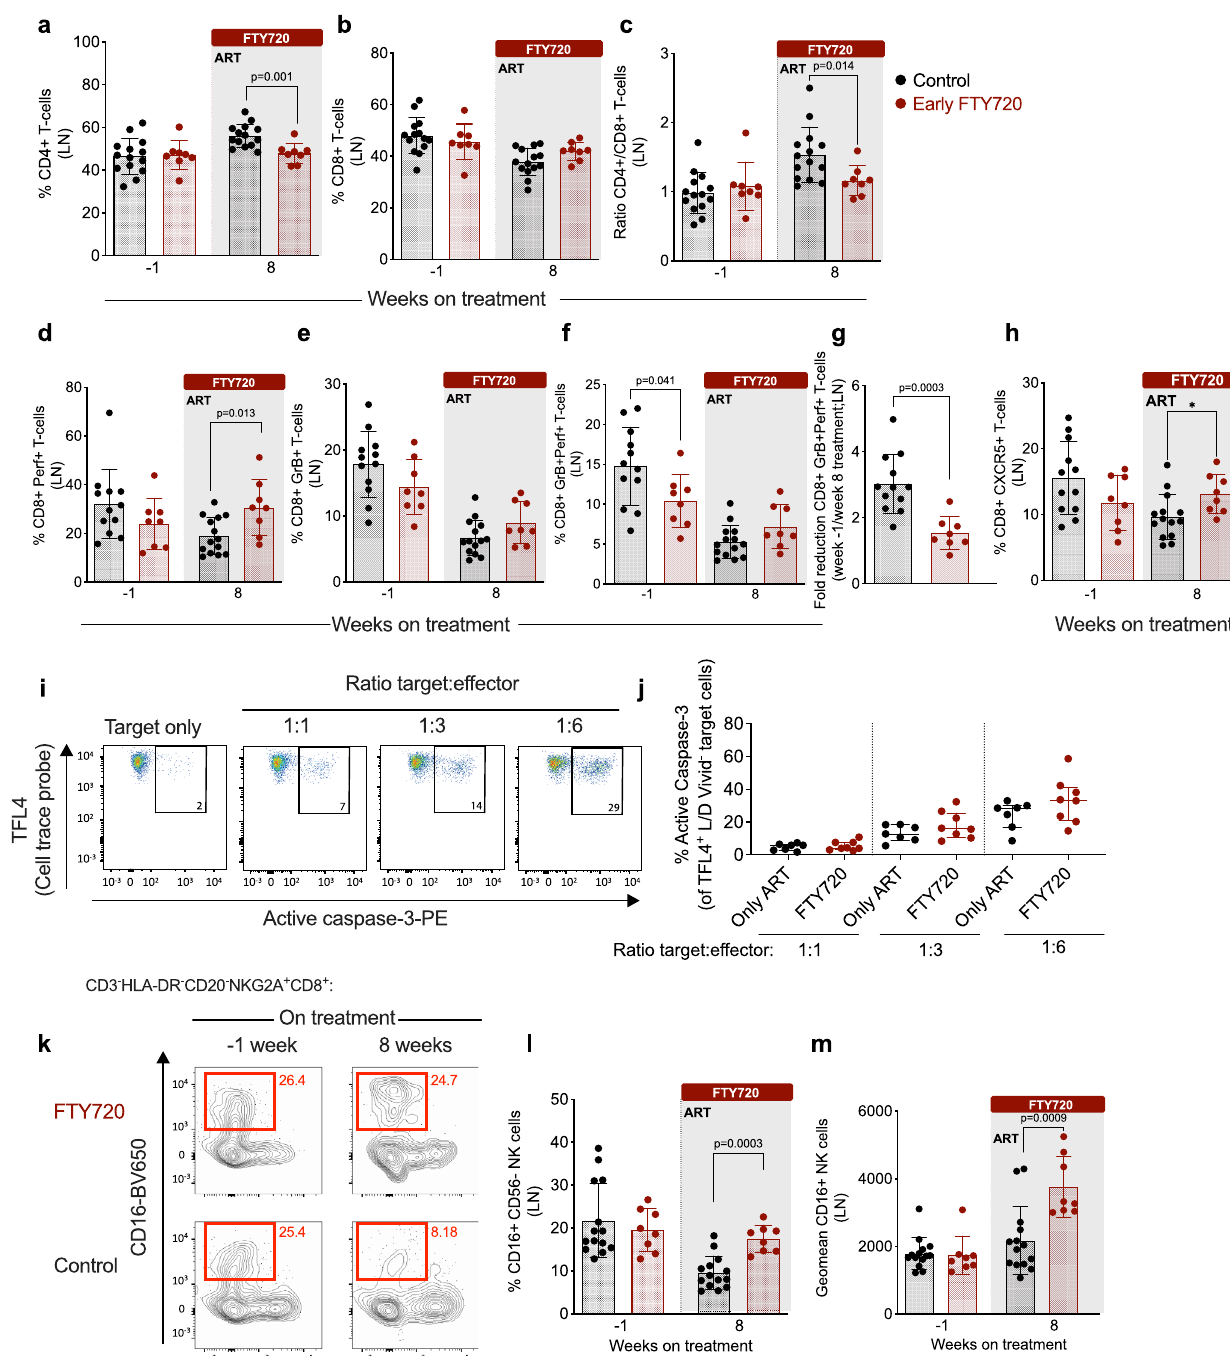
Fig. 2 | FTY720 treatment in the fi rst weeks of ART retains cytolytic cells but does not enhance their functionality in the LN. a Frequency of CD4+ T cells, b CD8+Tcells,and( c )ratioofCD4+/CD8+Tcellsinlymphnode(LN)mononuclear cells at baseline (week − 1) and at 8 weeks of treatment in early FTY720 ( n =8 RMs) or control (n=14 RMs) SIV-infected RMs. d Frequency of LN perforin+ (Perf+), e granzyme B (GrB+), and ( f ) Perf+GrB+ CD8+ T cells at baseline (week − 1) and at 8weeksinearlyFTY720(red)orcontrol(black)SIV-infectedRMs. g Foldreduction between week − 1 and week 8 of Perf+GrB+ CD8+ T cells, and ( h ) frequency of LN CD8+TcellsexpressingCXCR5atbaseline(week − 1)andat8weeksinearlyFTY720 ( n =8 RMs) and control ( n =14 RMs) SIV-infected RMs. i Representative fl ow cyto- metry staining of P185 mastocytoma target cells (TFL4+ cells) expressing active